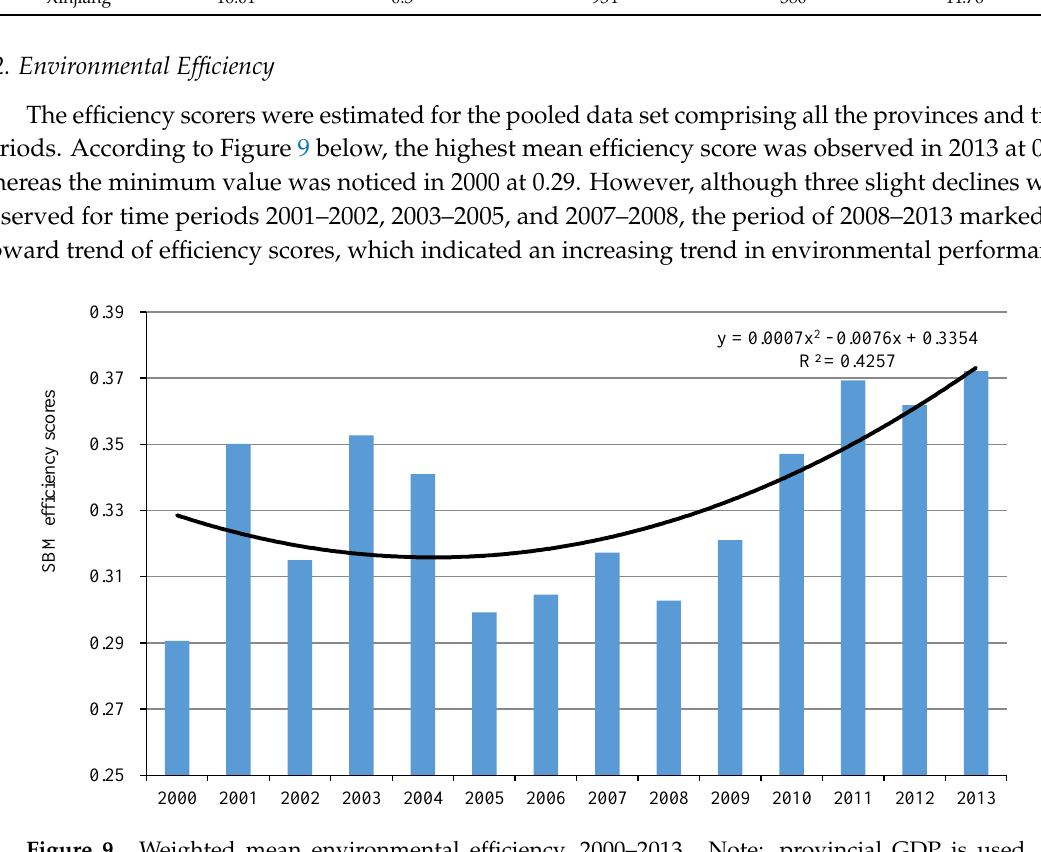
Figure 9. Weighted mean environmental efficiency, 2000–2013. Note: provincial GDP is used for weighting.